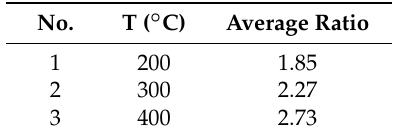
Table 11. Average ratio of cutting force